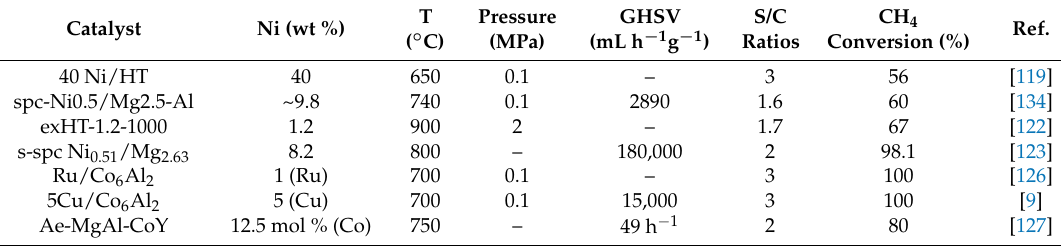
Table 4. Catalytic performance of steam reforming of CH 4 for different catalysts in different